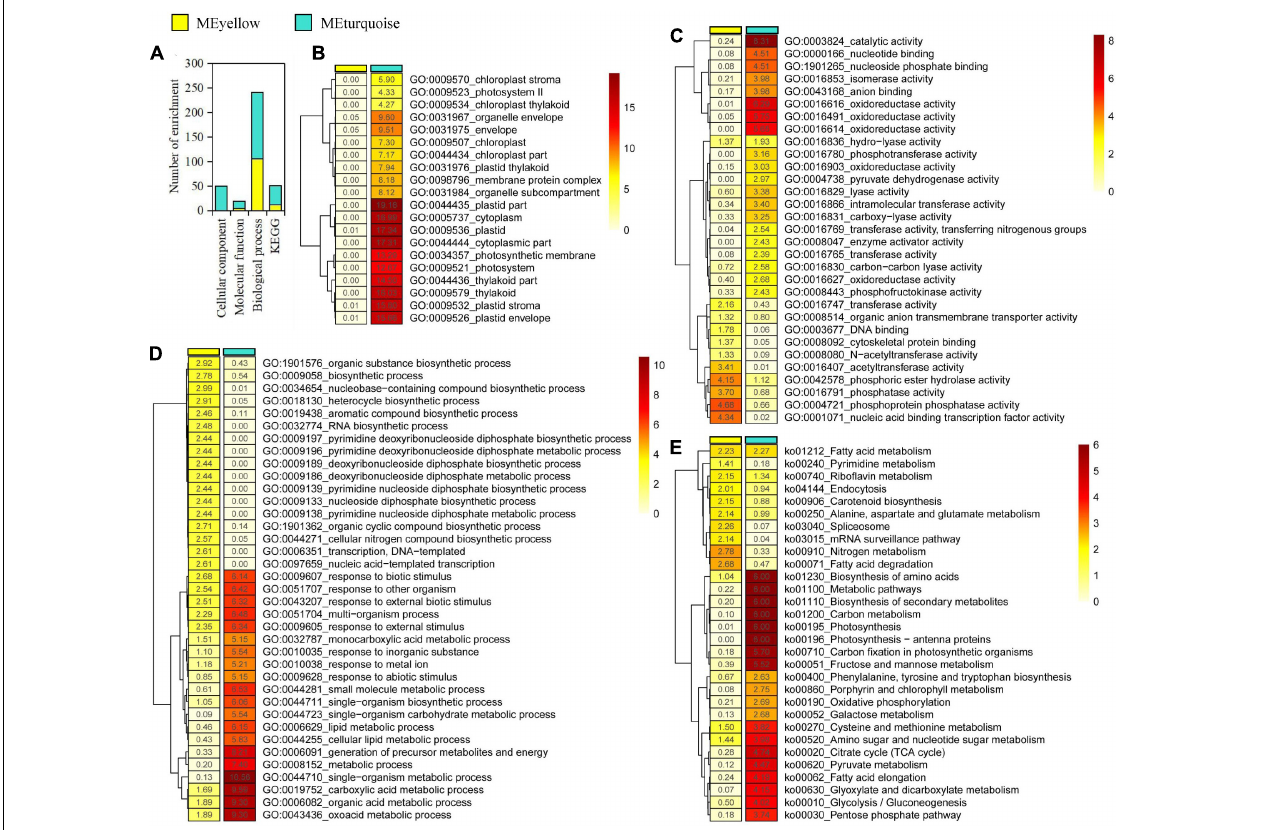
FIGURE 2 | Gene enrichment analysis in yellow and turquoise modules. (A) Statistics of significantly enriched genes. (B–E) Heat maps of -log10 enrichment p -values for the 20 most-enriched Gene Ontology terms and Kyoto Encyclopedia of Genes and Genomes pathway in the shared